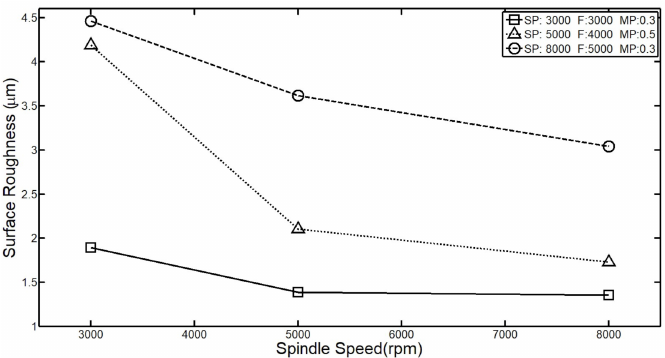
Figure 4. The influence of spindle speed on surface roughness.